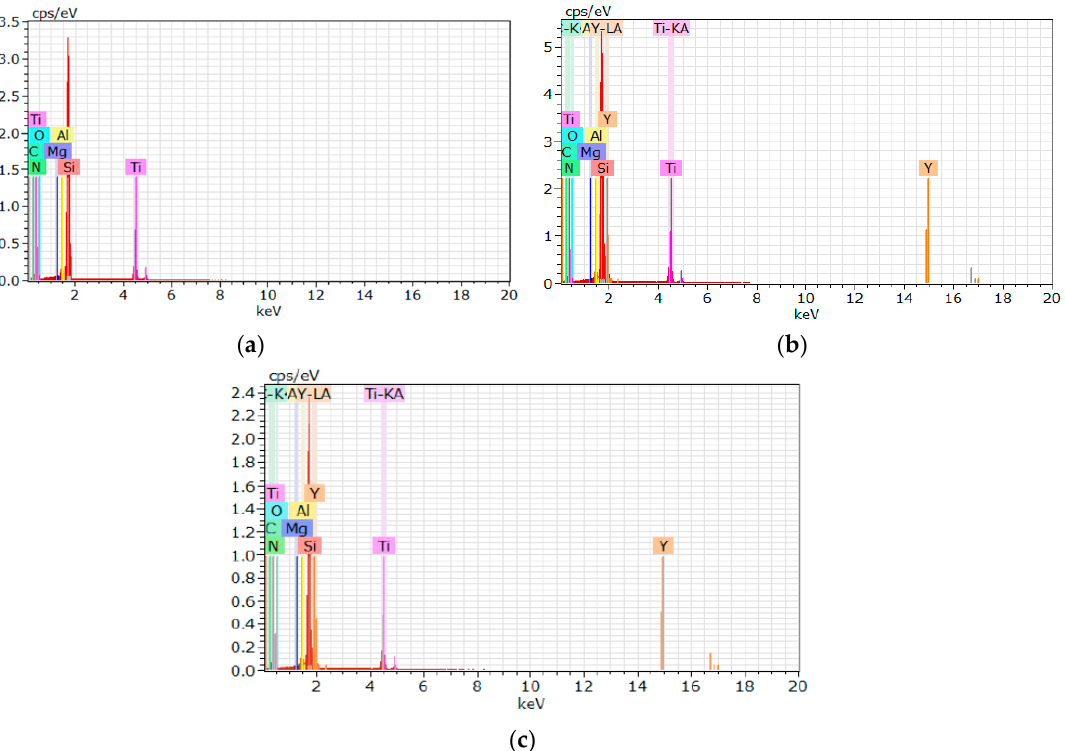
Figure 3. EDS analysis of di ff erent chemical compositions of the IS9 inserts: ( a ) Before ion implantation; ( b ) after yttrium ion implantation at dose 1 × 10 17 ion / cm 2 ; ( c ) after yttrium ion implantation at dose 2 × 10 17 ion / cm 2